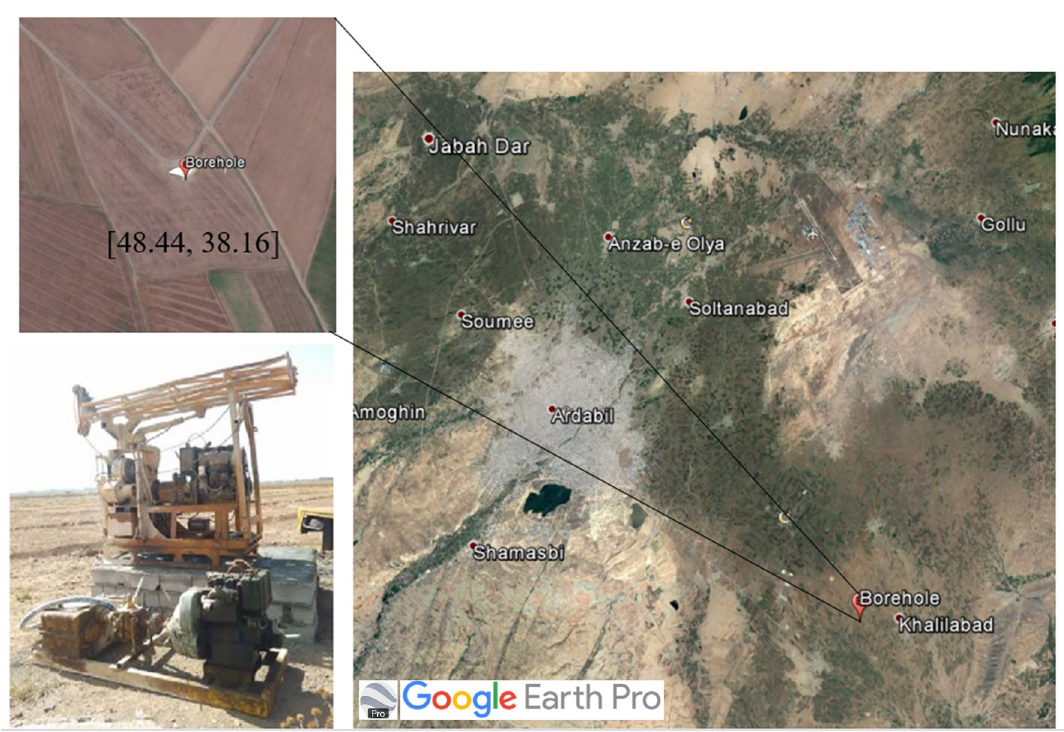
Figure 19. Drilling site of a borehole 105 m deep in the field. The map in this figure was created using the Google Earth/Pro version 7.3.4.8573 software (https:// earth. google.